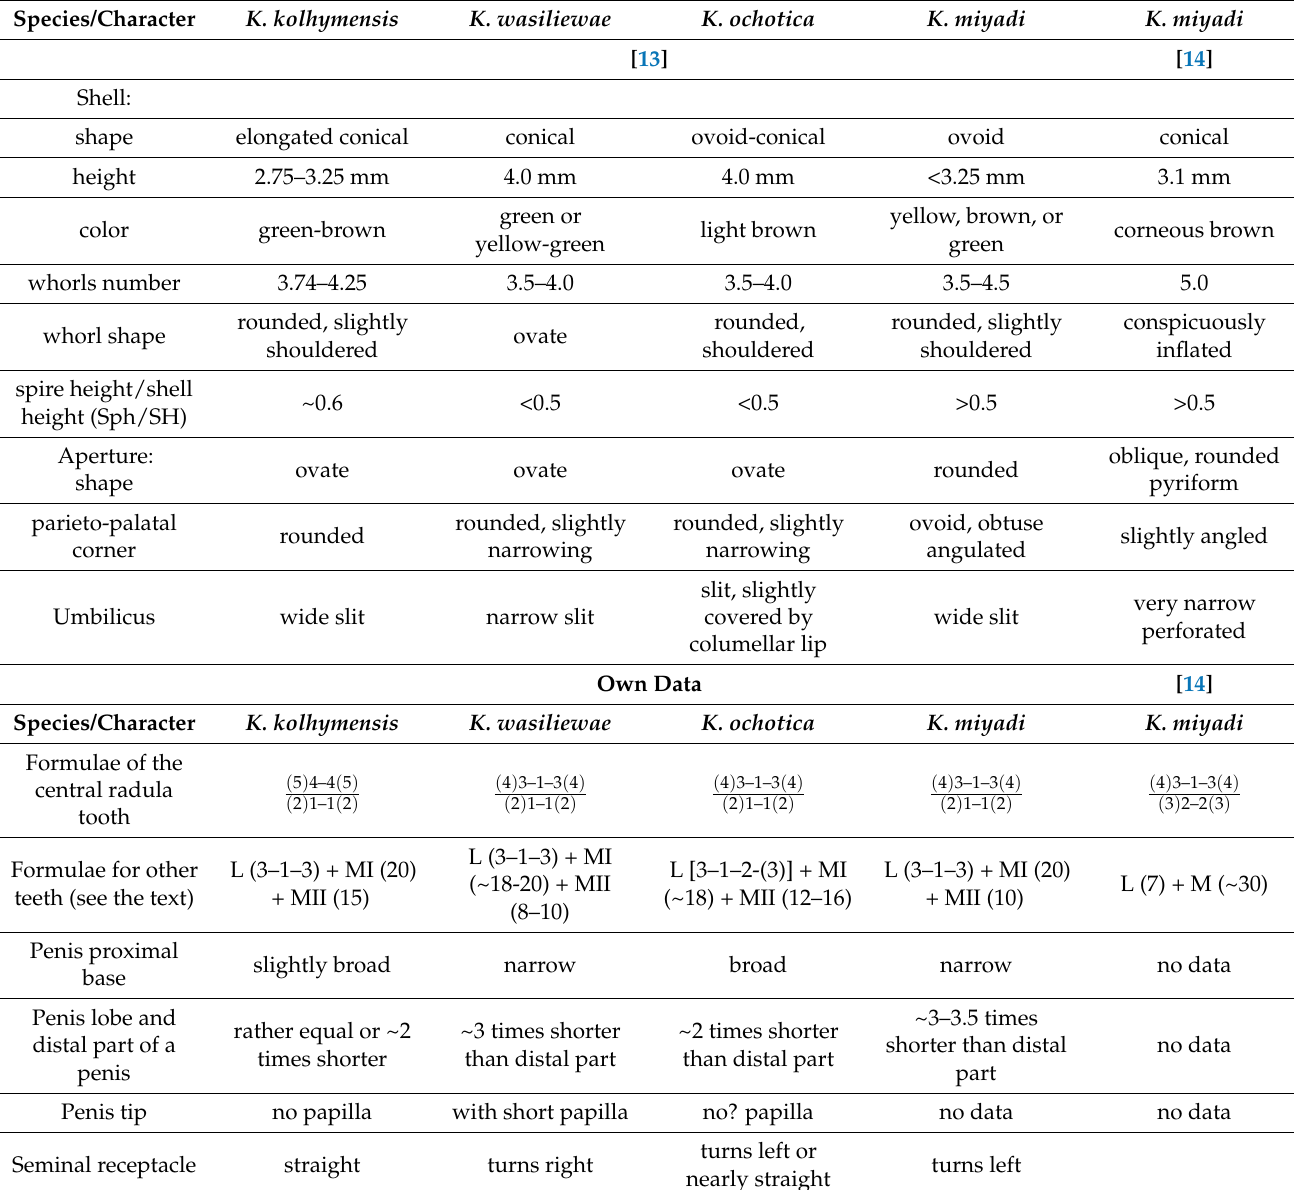
Table 2. Morphological and anatomical characteristics of Kolhymamnicola species, adapted from [13,14] and our own